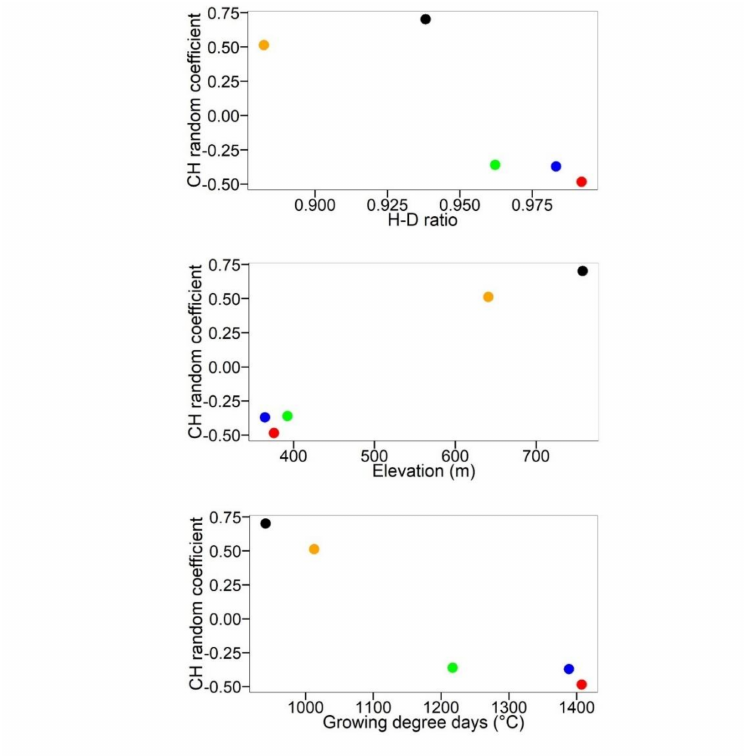
Figure 3. Scatter plots of Model 4 canopy height (CH) random coefficients plotted against the height–diameter ratio (H–D ratio), the elevation, and the growing degree day variables presented by study